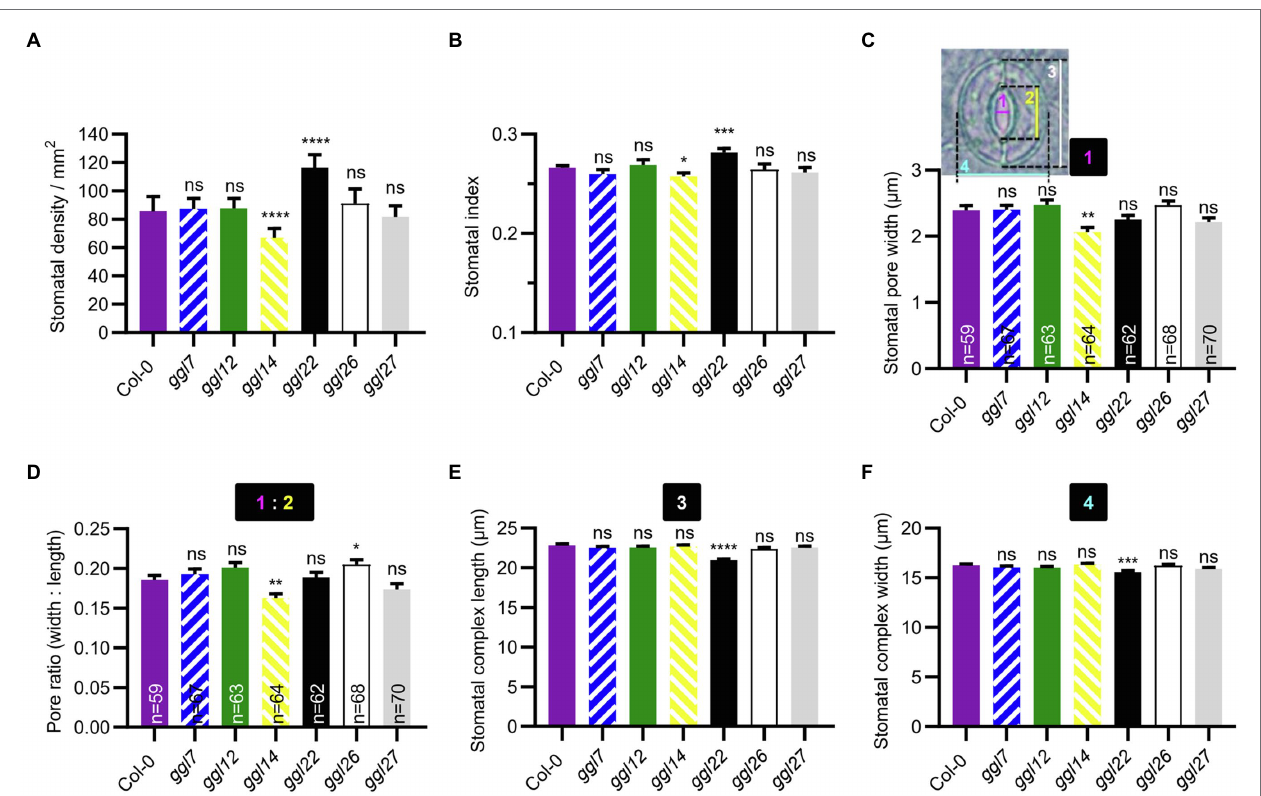
FIGURE 8 | Stomatal density and stomatal morphology of ggl single mutants. (A, B) Stomatal density (A) and stomatal index (B) in the abaxial leaves of Col-0 and ggl single mutants. Values are means ± SE ( n = 3 independent experiments, each with at least 8 leaves per genotype). * p < 0.05; *** p < 0.001; **** p < 0.0001; ns, no significant difference; Student’s t -test. (C–F) Stomatal pore width (C) , pore ratio (width: length) (D) , stomatal complex length (E) , and width (F) of Col-0 and ggl single mutants. Number 1 represents stomatal pore width, 2 represents stomatal pore length, 3 represents stomatal complex length, and 4 represents stomatal complex width. Pore ratio (1:2) is the ratio of pore width to pore length. Data are means ± SE, n = 60 stomata from at least six leaves per genotype (E) and (F) . * p < 0.05; ** p < 0.01; *** p < 0.001; **** p < 0.0001; ns, no significant difference; Student’s t -test. The measurement of stomatal pore width and length, and stomatal complex length and width was indicated in (C)